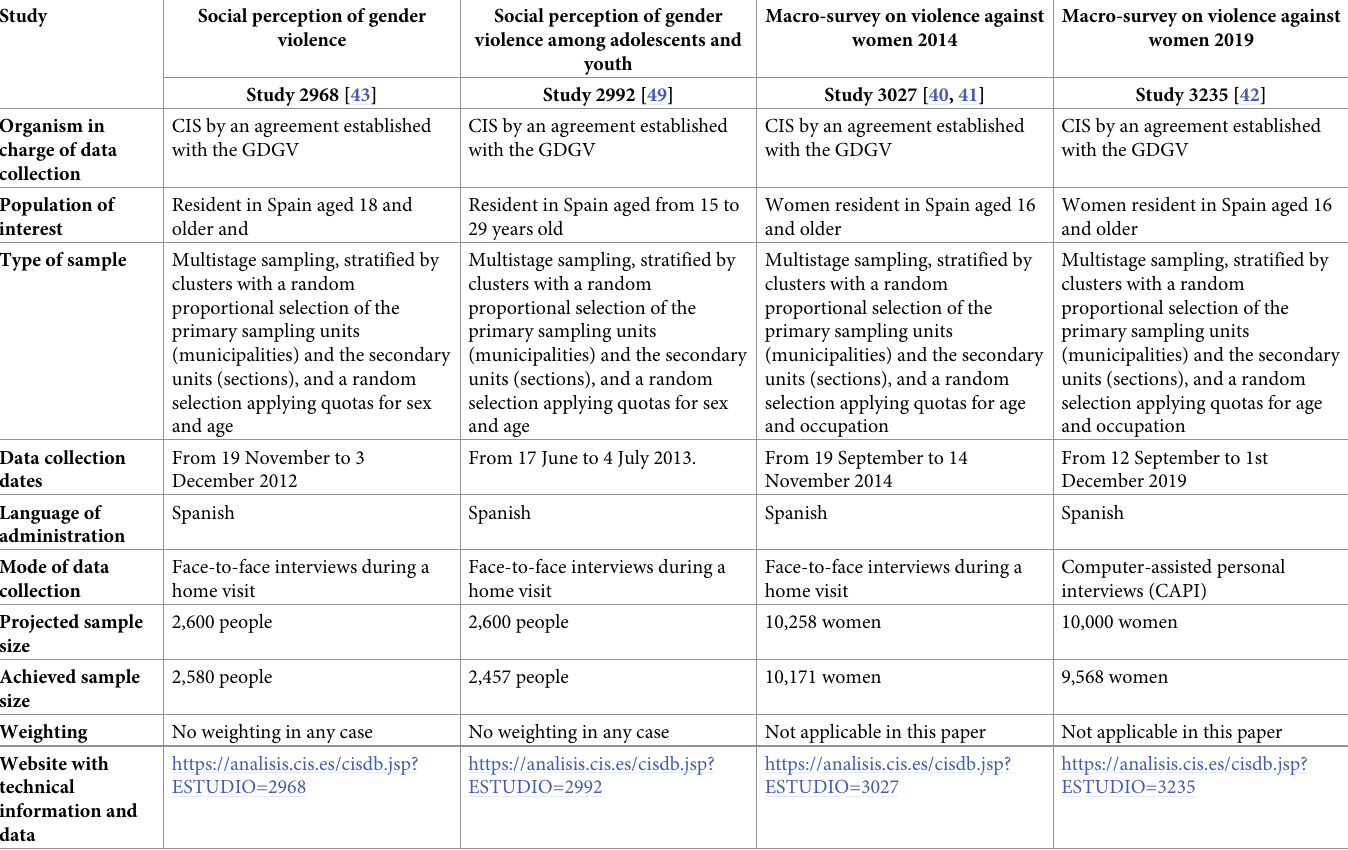
Table 1. Information about each sociological survey